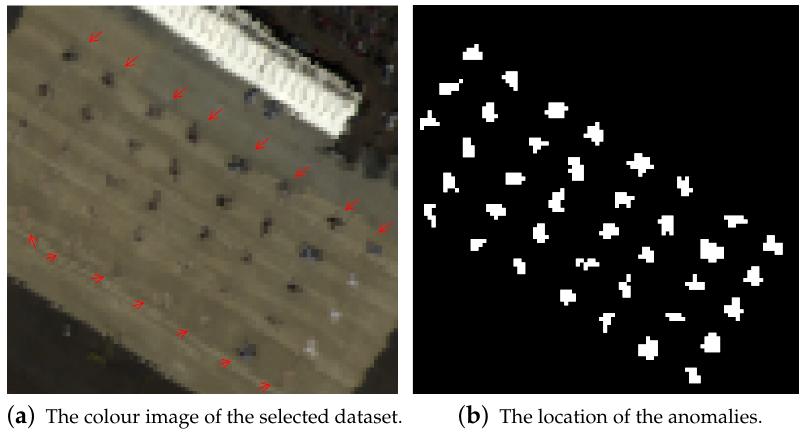
( a ) The colour image of the selected dataset. ( b ) The location of the anomalies. Figure 6. The colour image and the ground truth image of Sandiego data set.